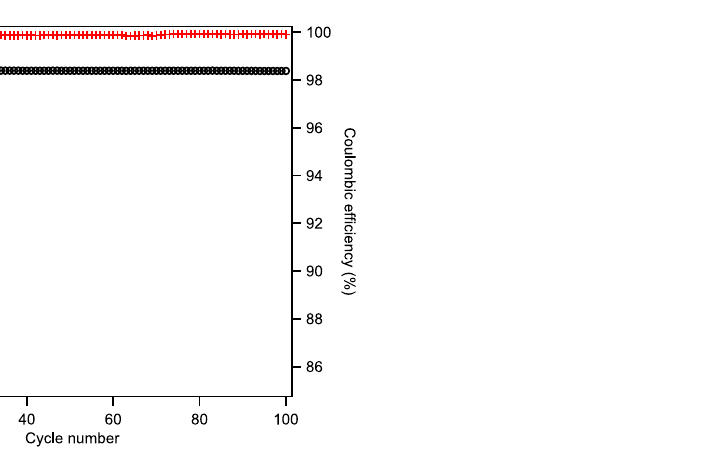
Figure 6. Capacity (black circles) and Coulombic efficiency (red crosses) of BCG made from 230 to 140 mesh